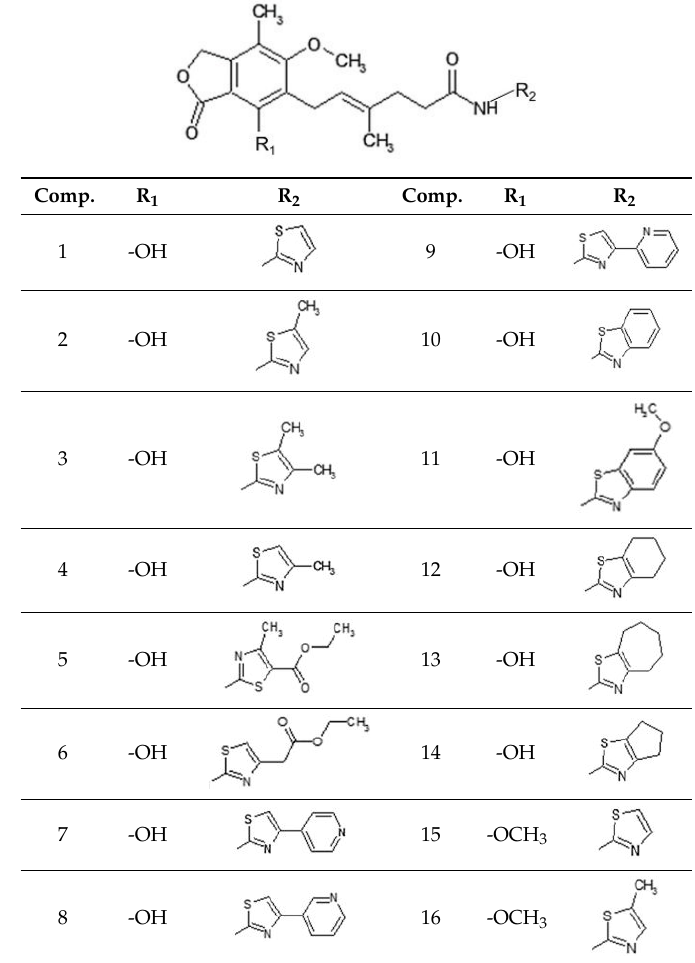
Table 1. Structure of the designed